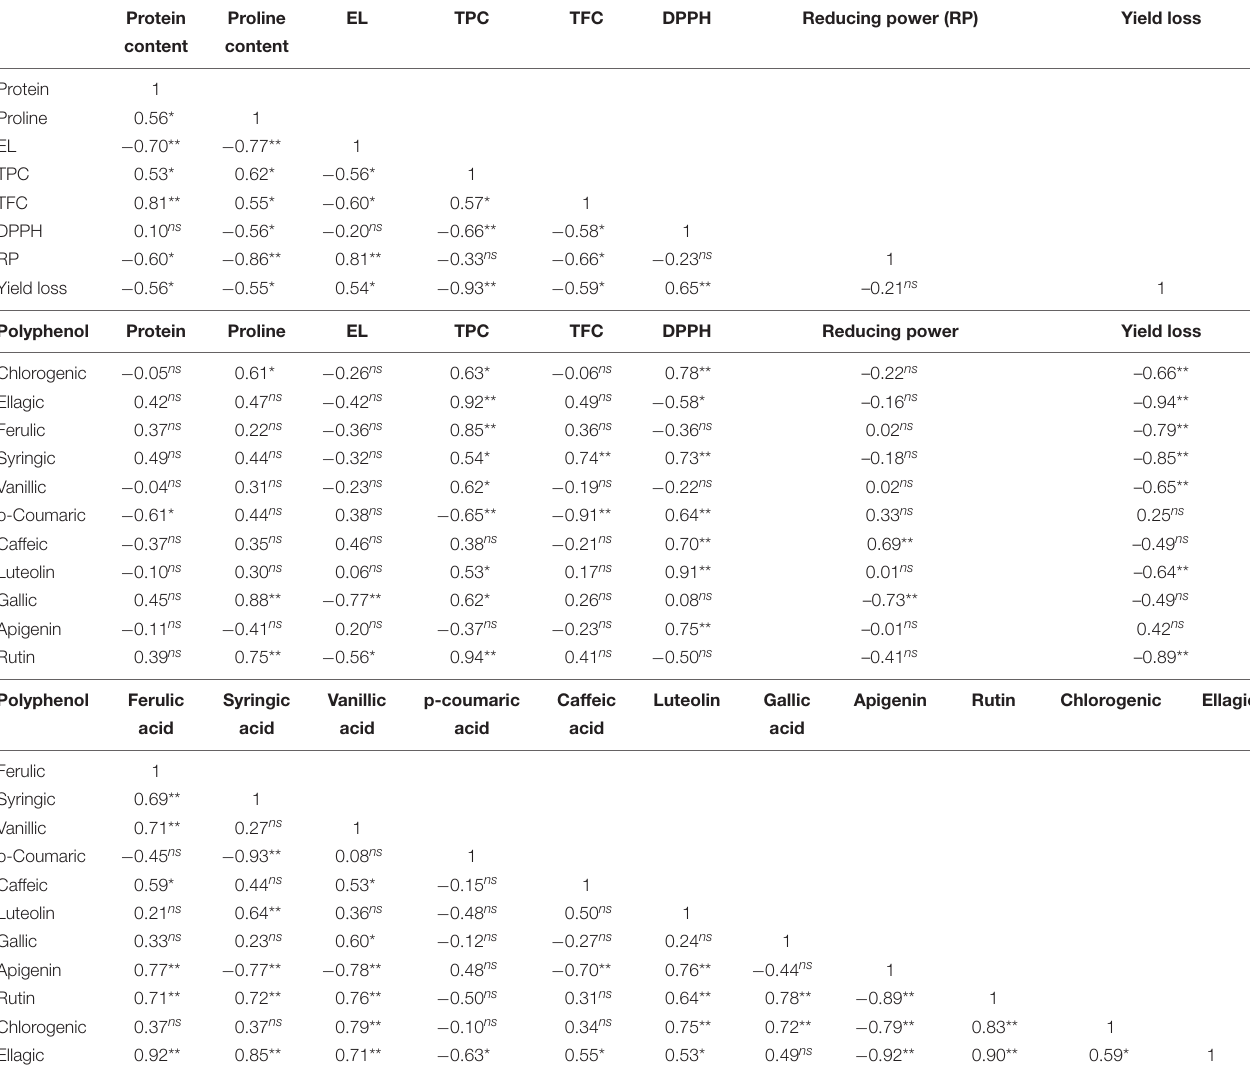
TABLE 6 | Correlation coefficients of biochemical traits, polyphenols and yield loss.